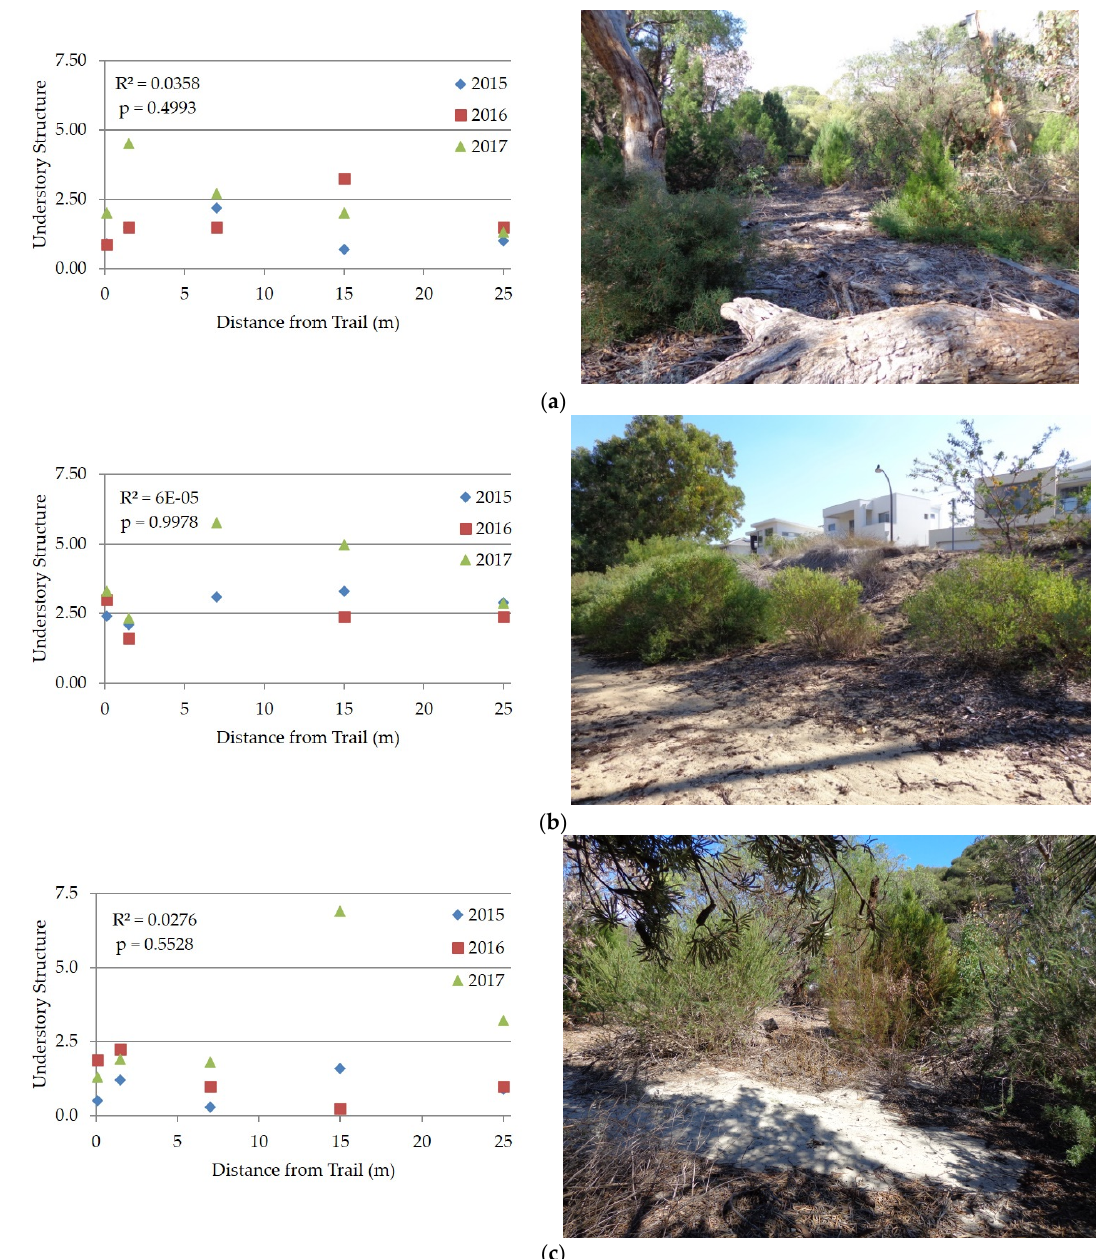
Figure 4. From ( a )–( c ), the measured (highest totally covered row of 10 × 0.01 m × 0.01 m cells in a 1 m × 1 m frame) and observed structure of the understory in the fenced Banksia and eucalyptus woodland, and the unfenced Banksia and eucalypt woodland, and the unfenced Banksia woodland at the Lake Claremont study site. As with Figure 3, example photographs taken at waist height from the 15 m quadrat looking back along the transect towards the